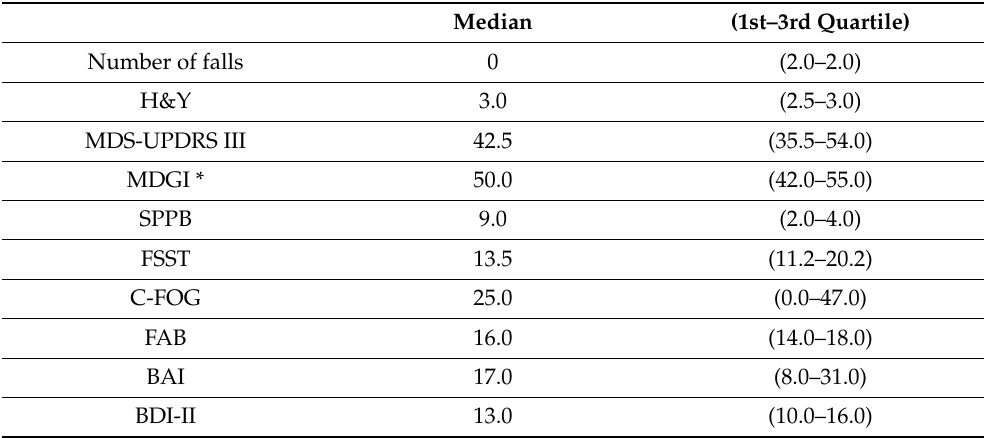
Table 2. Clinical characteristics of the sample of persons with Parkinson’s disease enrolled in this